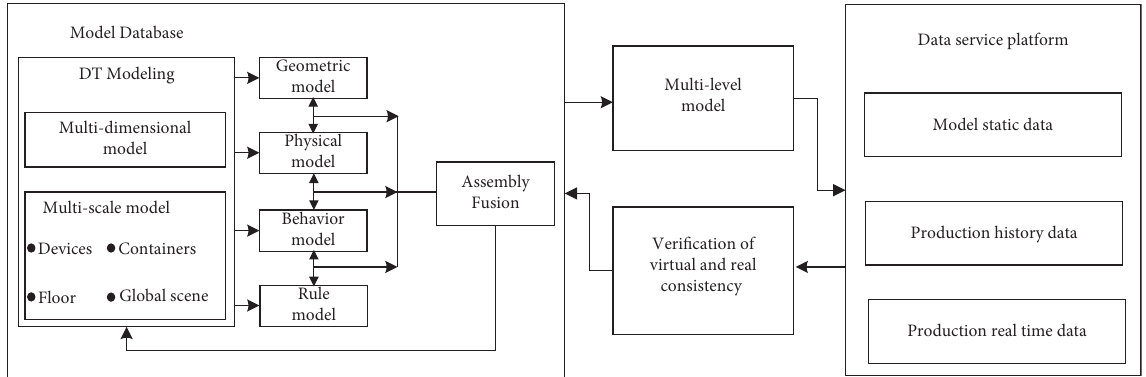
Figure 4: Verification of virtual and real consistency of the full-factor DT entity model for the ACT.